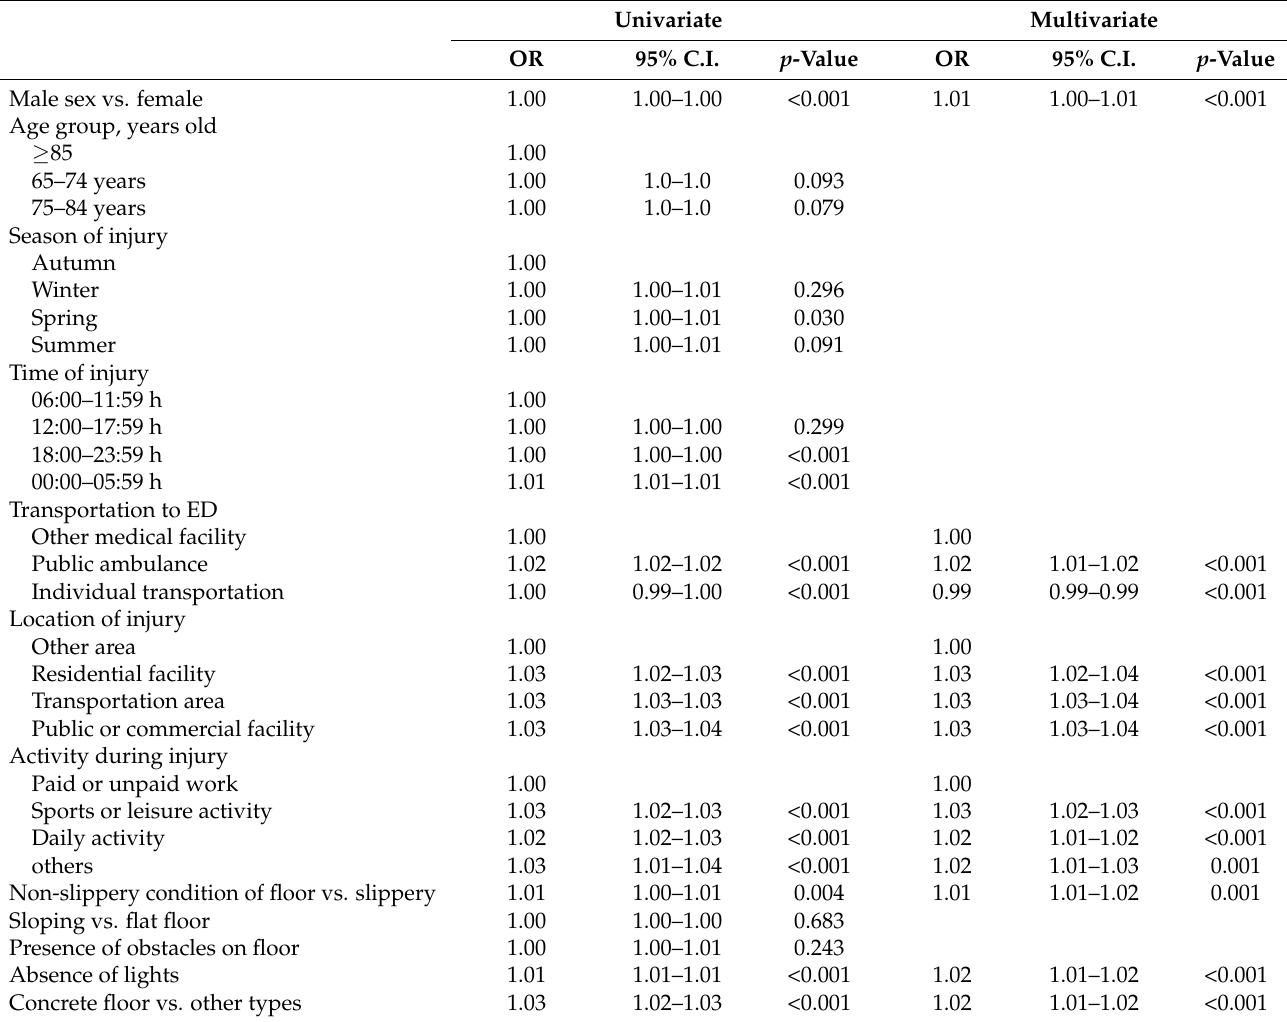
Table A2. Factors associated with alcohol intake and ground-fall injuries in the